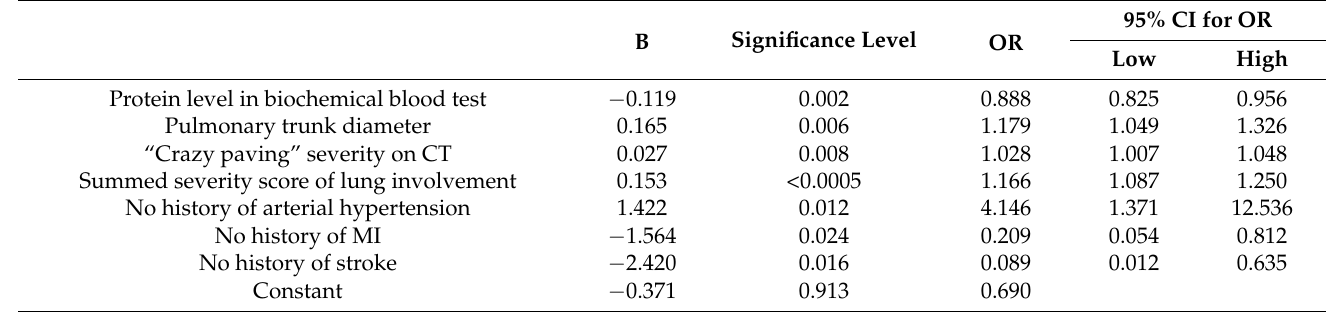
B—value for the logistic regression equation for predicting the dependent variable from the independent variable, OR—odds ratio, CI—confidence